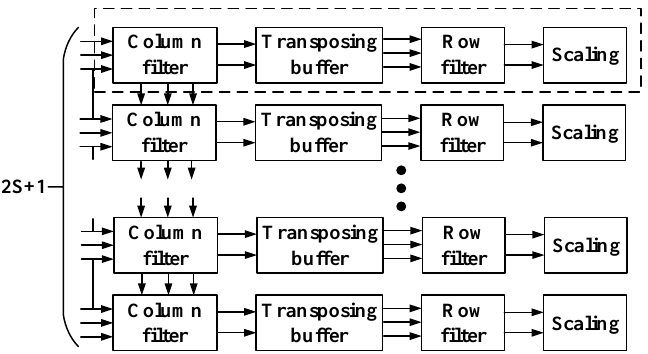
Figure 5. Architecture of a single-level 2-D DWT with parallelism S.